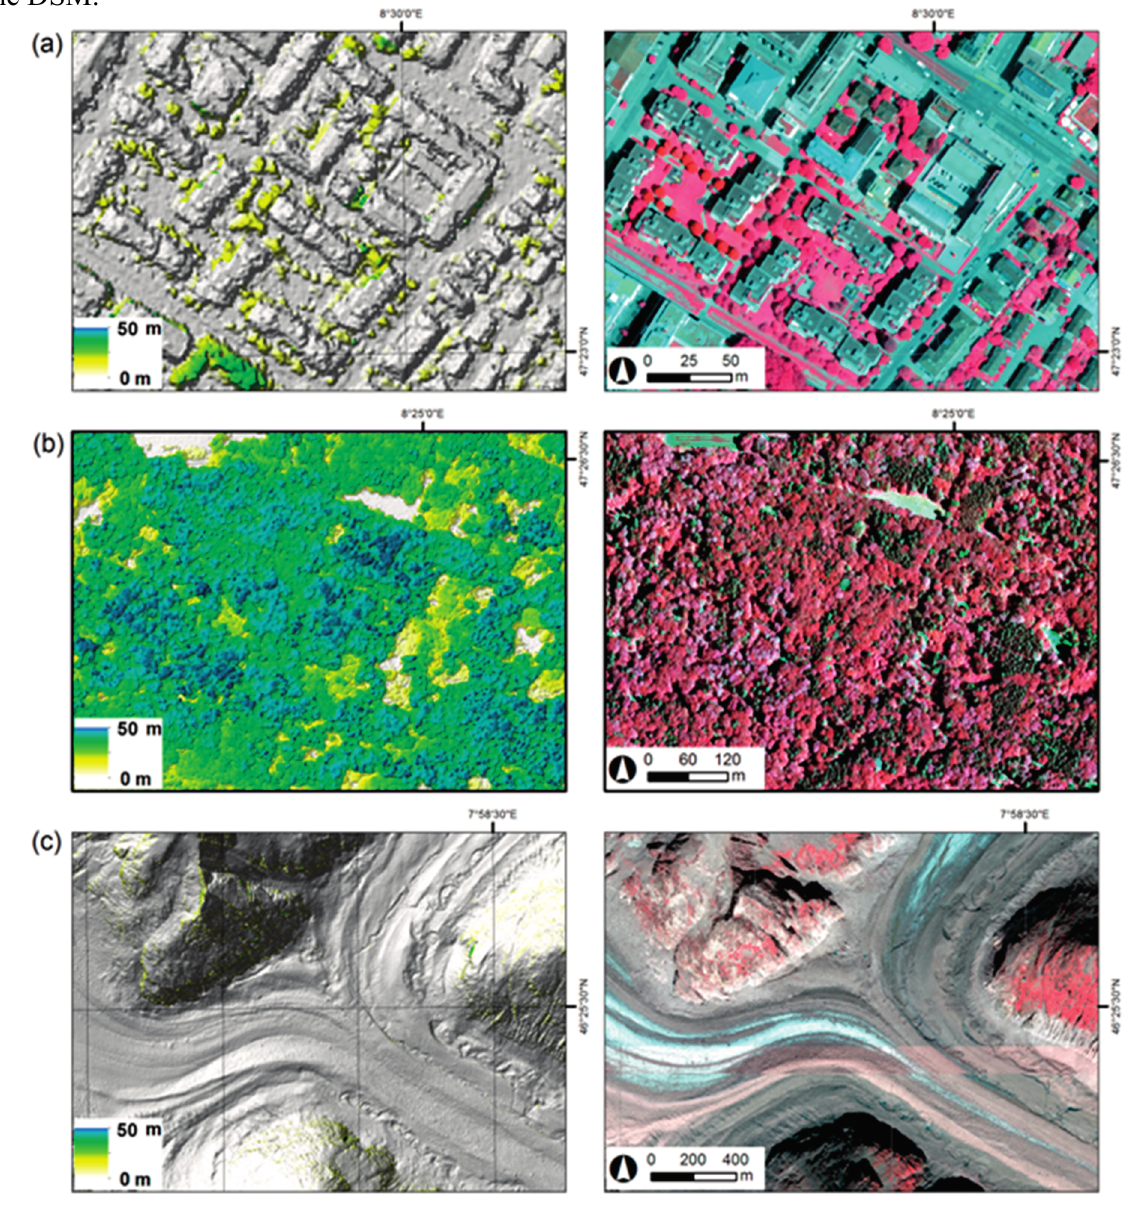
Figure 5. Shaded relief of the generated DSM with a colour gradient for canopy height (0–50 m) on the left and the used ADS80 input image data on the right: ( a ) buildings in Zurich, ( b ) forests in the Swiss lowlands and ( c ) glaciers in the